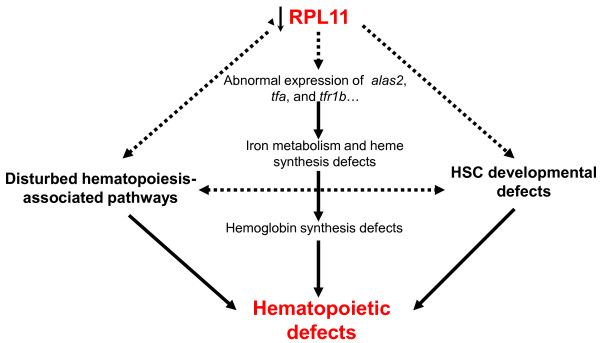
Potential molecular mechanisms by which Rpl11 deficiency leads to hematopoietic defects in zebrafish embryos. In this study, we deduced three potential mechanisms by which Rpl11 deficiency leads to hematopoietic defects in zebrafish embryos. First, Rpl11 deficiency led to abnormal expression of a set of iron metabolism- and heme synthesis-related genes. Second, Rpl11 deficiency disturbed proliferation and development of HSCs. Finally, Rpl11 deficiency disturbed several hematopoiesis-associated pathways. Solid lines represent mechanisms that have been confirmed in this or other studies, and dashed lines represent mechanisms that require further validation.